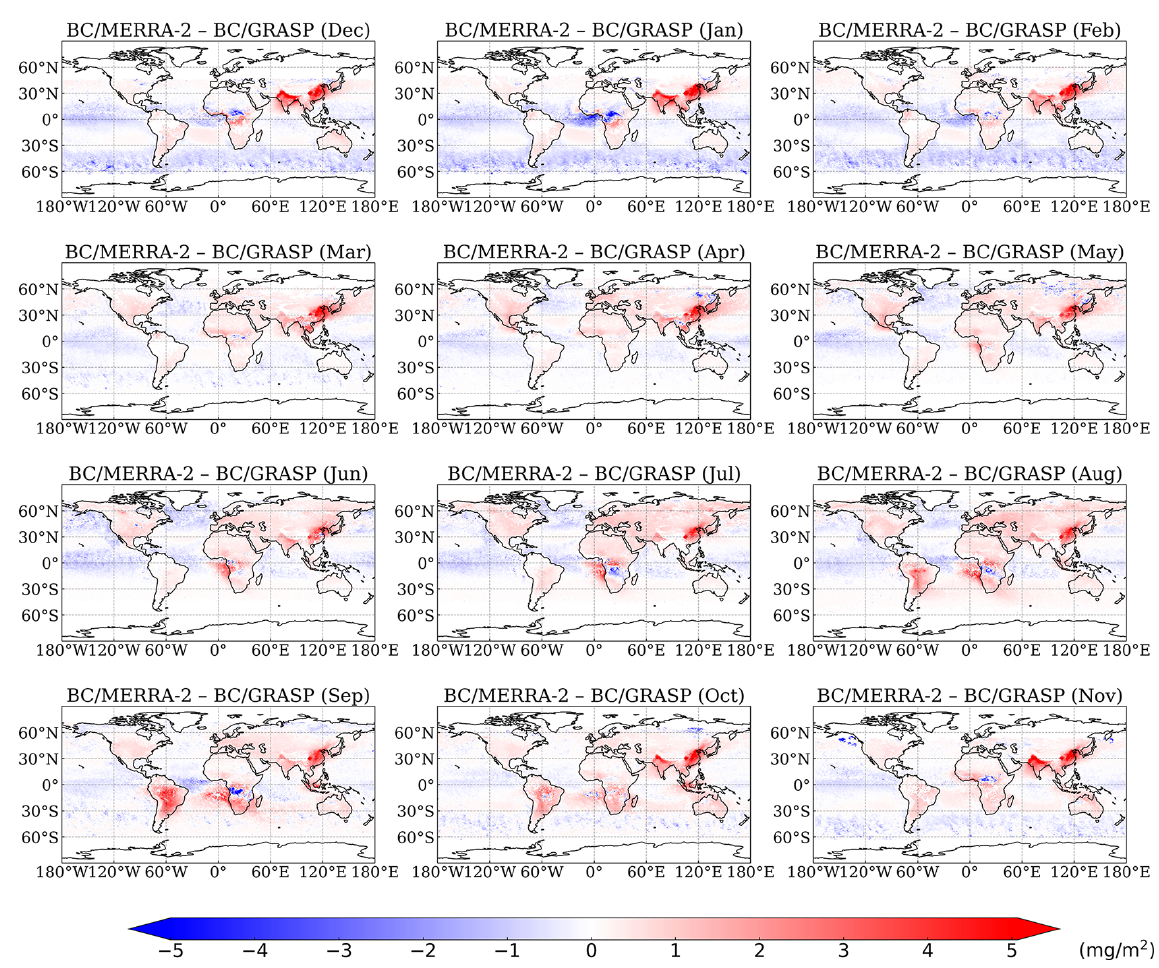
Figure 19. Differences of monthly BC column concentration between GRASP/Component and MERRA-2 in the resolution of 0 . 5 ◦ × 0 . 625 ◦ for the period March 2005–October